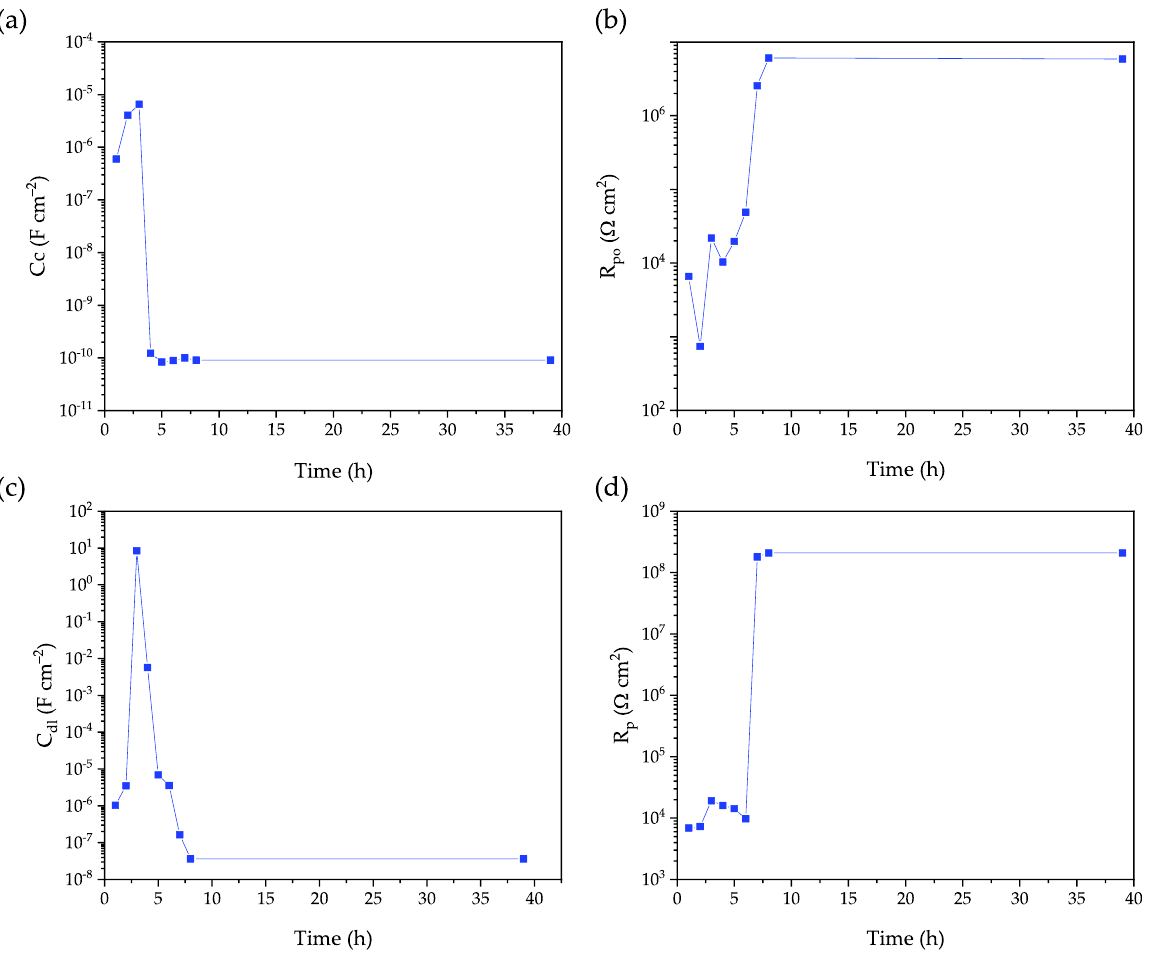
Figure 5. Evolution of the fitting parameters of the co-PPM 9% coating after the artificial damaging: coating capacitance, C c ( a ); pore resistance, R po ( b ); double layer capacitance, C dl ( c ), and polarization resistance, R p ( d ).